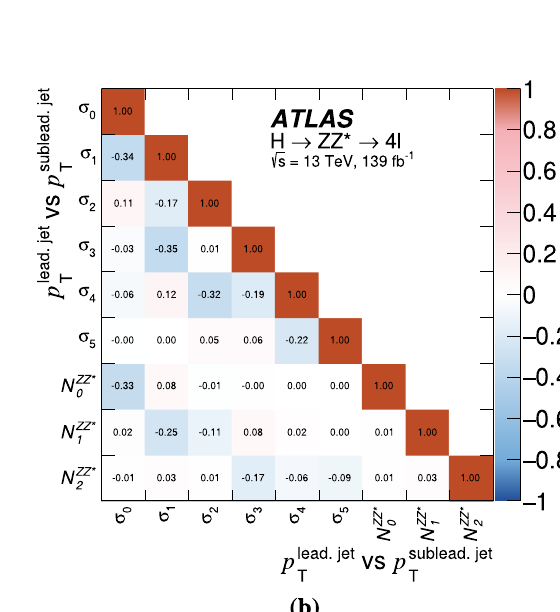
Fig. 39 a Double differential fiducial cross section for the transverse momentum of leading vs. subleading jet, p lead